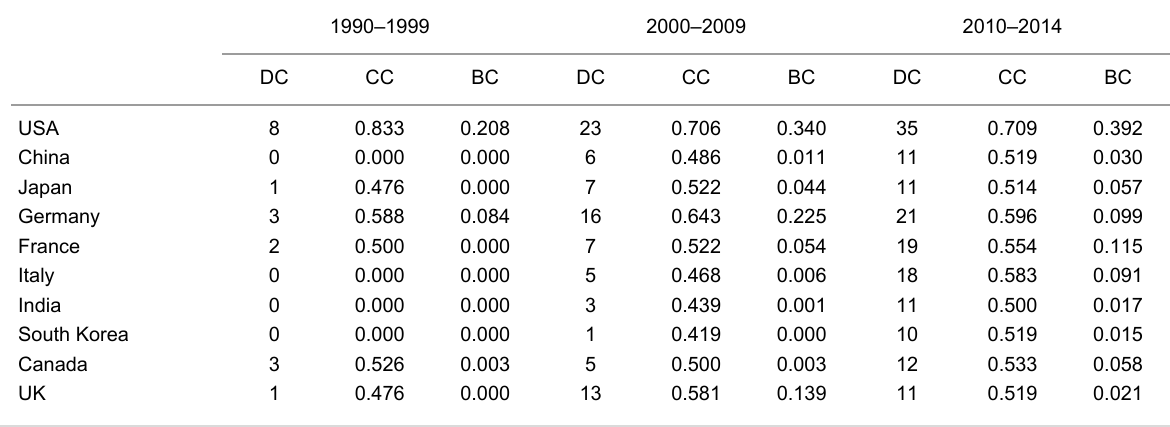
Table 2: Centrality analysis for top 10 countries in different stages.